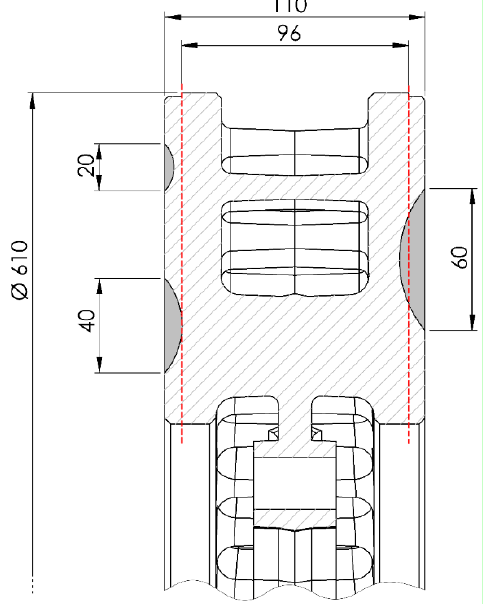
Figure 16. Visualization of three cracks with lengths of 20, 40 and 60 mm on the surface of the fragment of brake disc with dimensions of 610 mm × 110 mm; the red line marks the minimum thickness of the brake disc (96 mm).